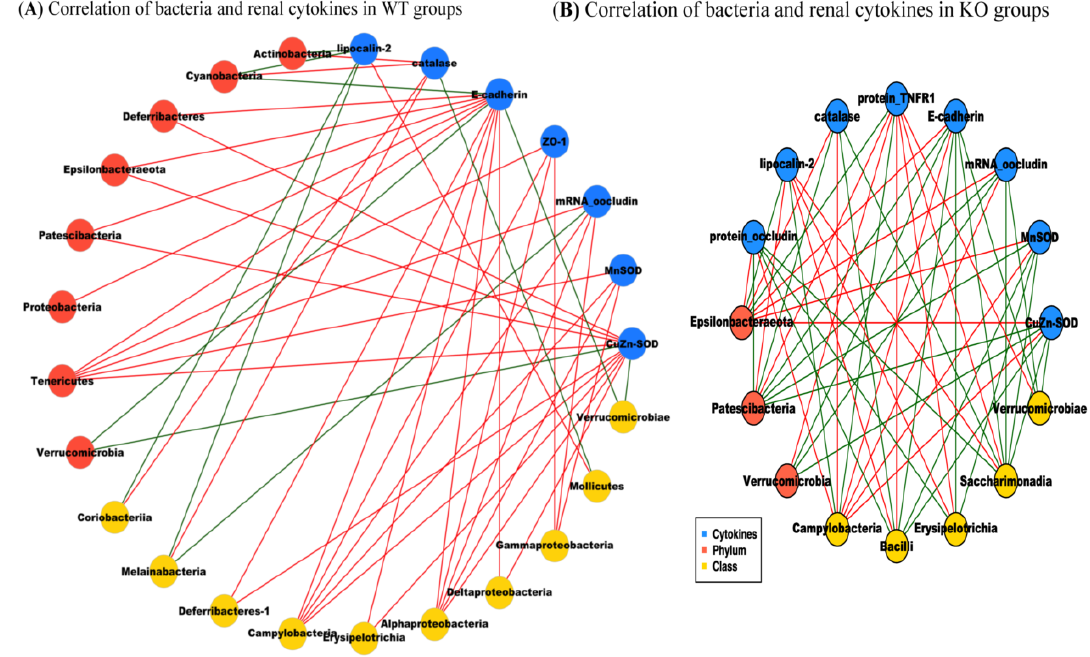
Figure 8. Crosstalk between intestinal and renal pathogenic markers in bile duct ligation (BDL) mice. ( A , B ) Significant correlation was noted between renal injury, renal inflammatory, anti-inflammatory, barrier markers and intestinal microbiota in WT groups (WT-BDL and WT-sham) and KO groups (SIRT1 IEC-KO -BDL and SIRT1 IEC-KO -sham). “Green” lines represent positive correlation between the abundance of pathogenic proteins and mRNA levels of corresponding pathogenic markers whereas “red” lines indicate the negative correlation between the abundance of the bacteria with protein and mRNA levels of corresponding pathogenic markers. Int. J. Mol. Sci. 2021 , 22 , x FOR PEER REVIEW